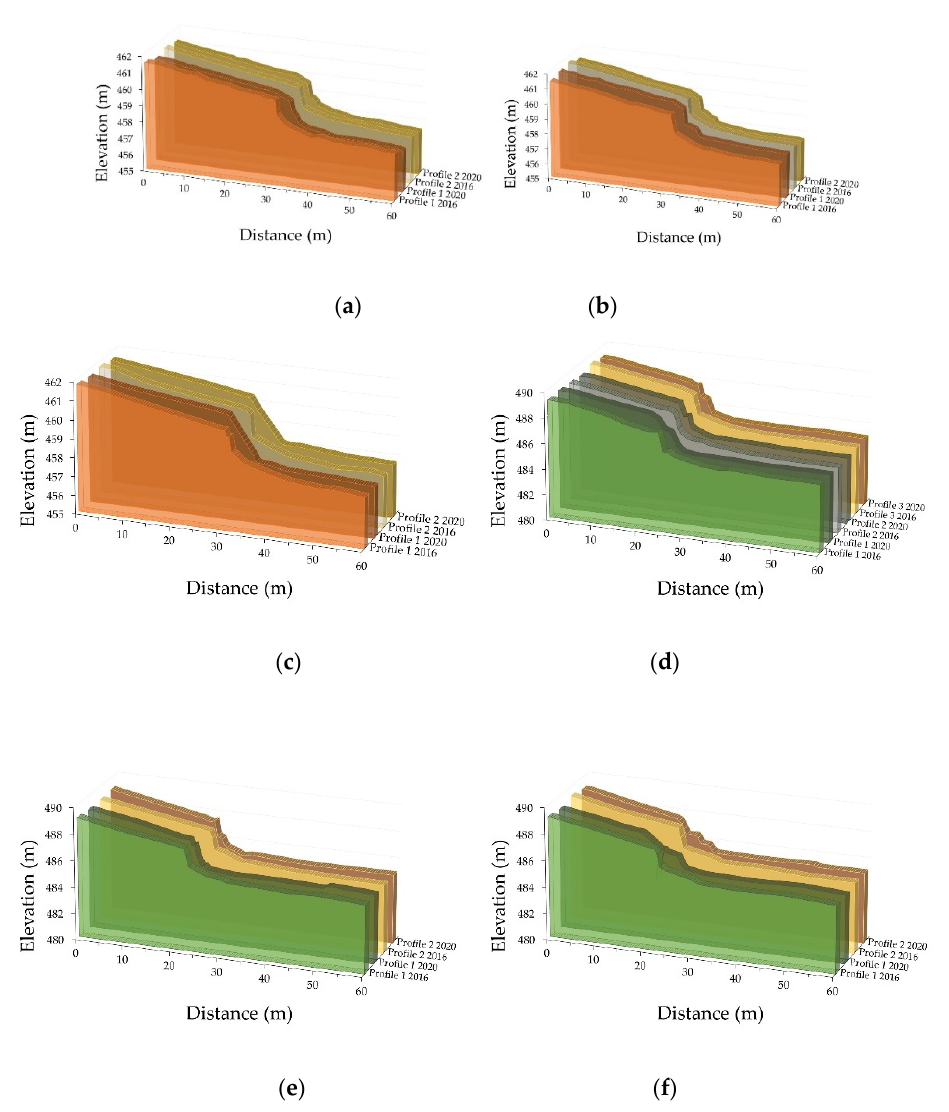
Figure 6. Differential Bathymetry: ( a ) PC1, ( b ) PC2, ( c ) PC3, ( d ) VG1, ( e ) VG2, and ( f ) VG3.